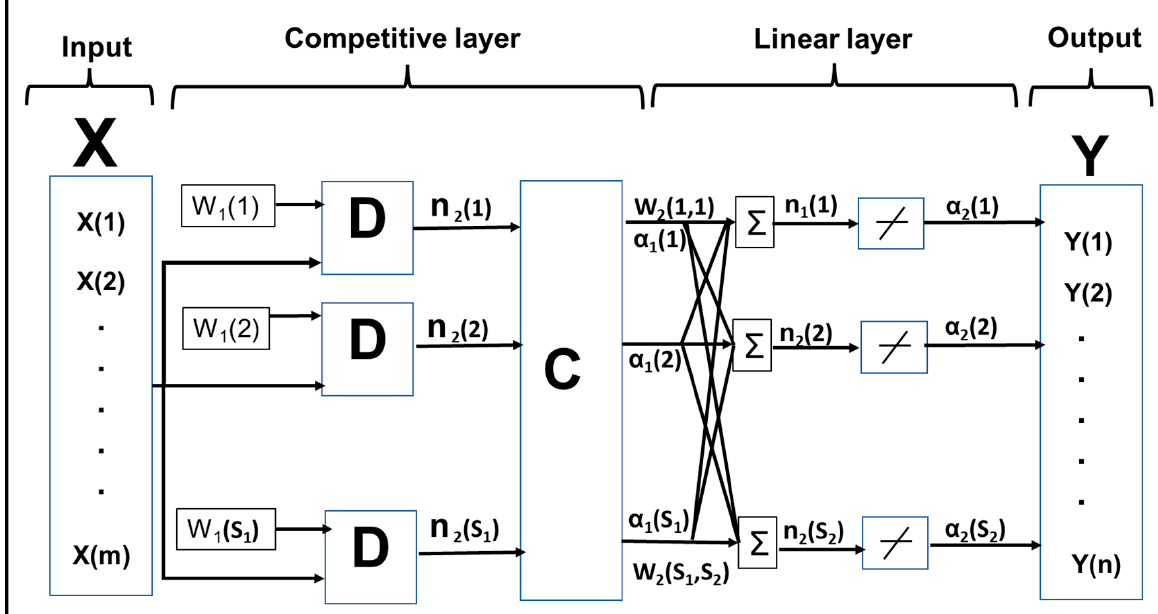
Figure 5. Structure of the LVQNN [19].